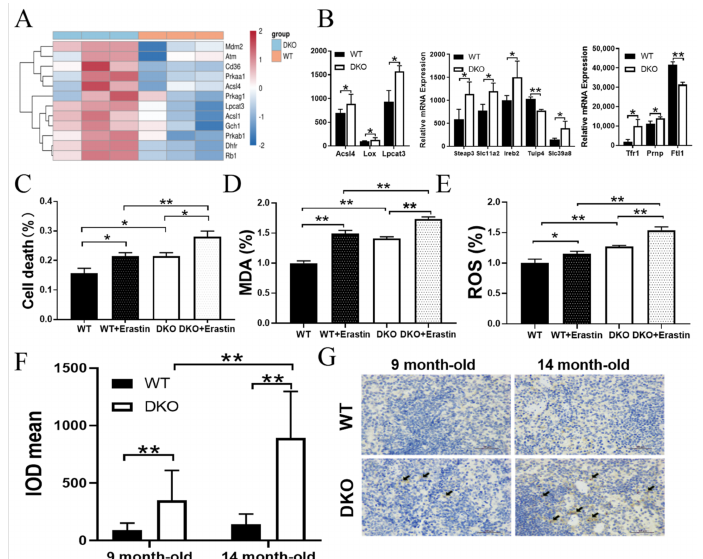
Figure 6. Expression analysis of spleen tissue and spleen lymphocytes. ( A ) Heat map of spleen DNA damage and ferroptosis gene expression levels in 14-month-old mice. ( B ) Relative mRNA expression of lipid peroxidation-related genes and iron metabolism-related genes. n = 3, * p < 0.05. ( C ) Cell mortality, ( D ) MDA levels, and ( E ) ROS levels of WT and DKO spleen lymphocytes from 14-month-old mice as well as treatment with 0.5 µ M erastin. Data are presented as mean ± SD, n = 6. * p < 0.05, ** p < 0.01. ( F , G ) IHC staining of spleen TFR1 in mice aged 9 and 14 months. Data are presented as mean ± SD, n = 3. ** p < 0.01.